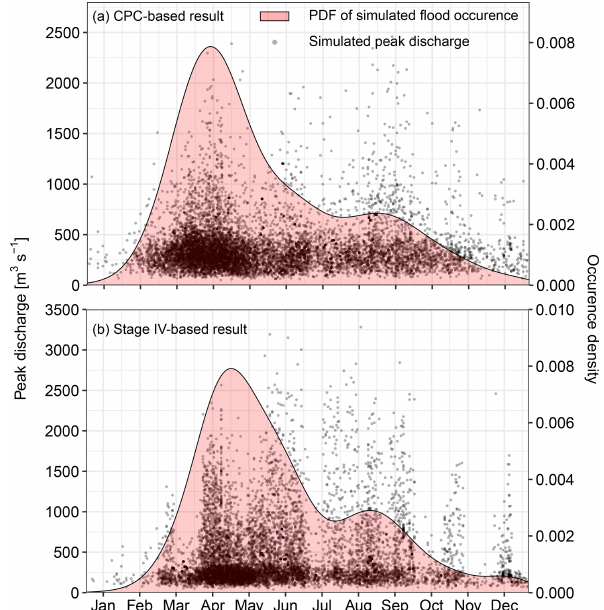
Figure 7. Time of occurrence during the year for simulated peak discharge in the Turkey River at Garber using (a) CPC and (b) Stage IV.